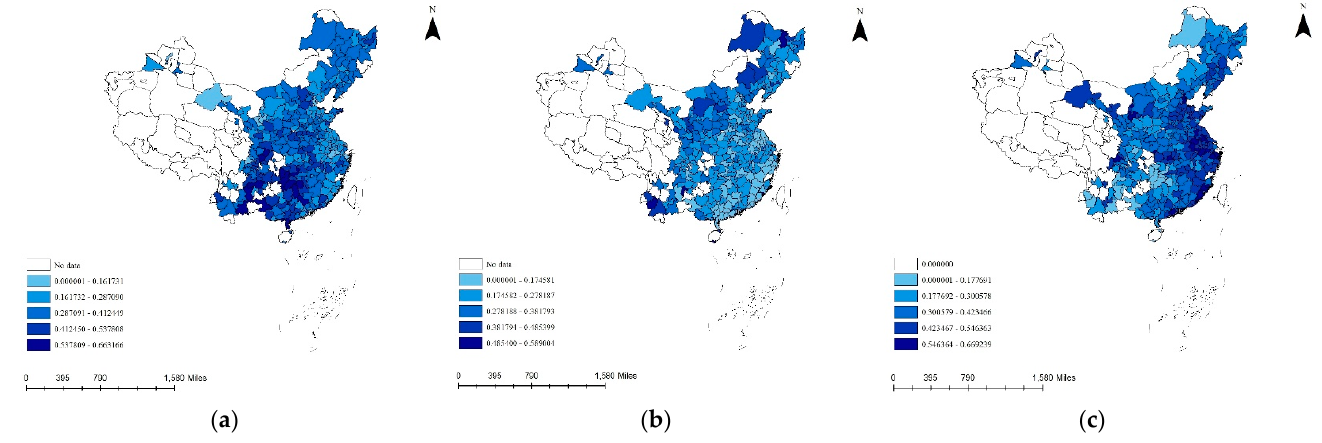
Figure 6. The spatial distribution of land transfer structure in the study area from 2010–2016. ( a ) The transfer structure of residential land. ( b ) The transfer structure of commercial land. ( c ) The transfer structure of industrial land.